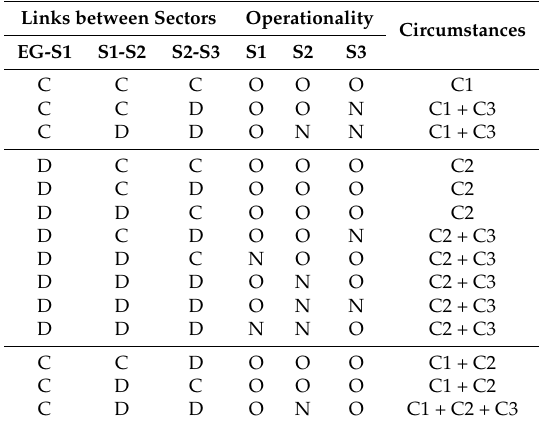
Table 3. Pilot Network scenarios depending on state of links and operability of sectors [30–32,39]. Links between Sectors